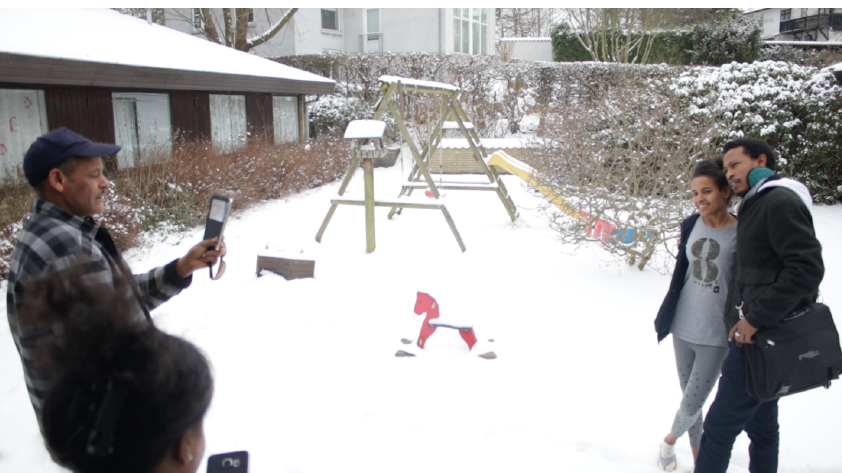
Figure 12. It was the first Danish winter for many of the residents of Hannebjerg. In early February, the first snow came, and the residents went outside to take pictures in the white scenery to share with their friends and families in Eritrea. February 2017.